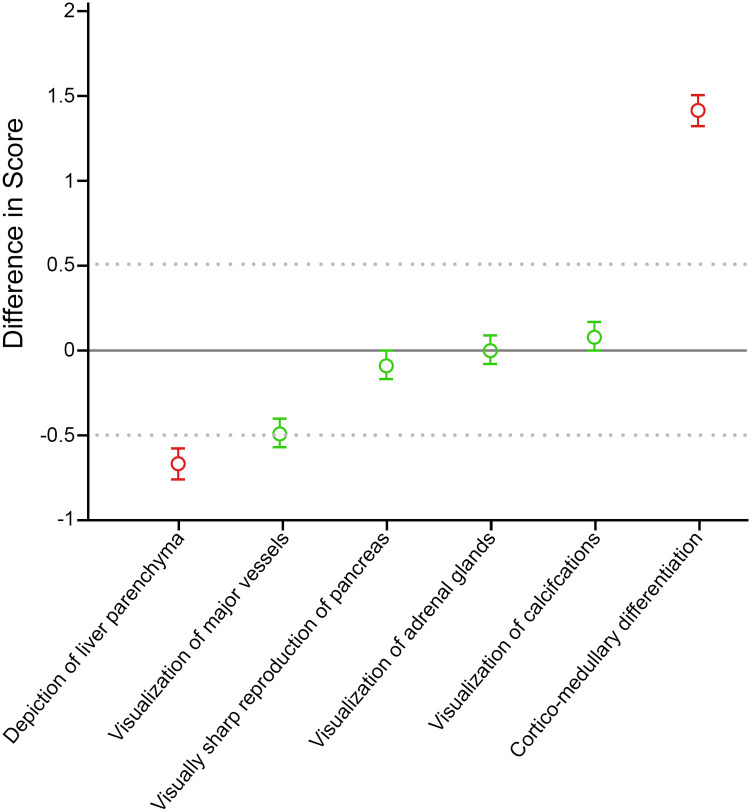
Qualitative differences between VUE and TUE images, based on Likert scores of radiologists.y-axis represents differences in Likert scores for VUE minus TUE. Red and green symbols represent the mean differences (β) and model 95% credible interval (CrI) in radiologists’ Likert scores between VUE and TUE images (see text for explanation). Gray dots reflect the boundary of clinical equivalence between VUE and TUE (±0.5 difference in Likert scores). Green symbols indicate that the measured difference between VUE and TUE lies within the calculated threshold range of equivalence. Red symbols indicate that the measured difference between VUE and TUE images is significantly greater than (i.e. outside) the calculated threshold difference of equivalence. Negative differences indicate inferiority of VUE compared to TUE; except for cortico-medullary differentiation, where a positive difference connotes greater differentiation.